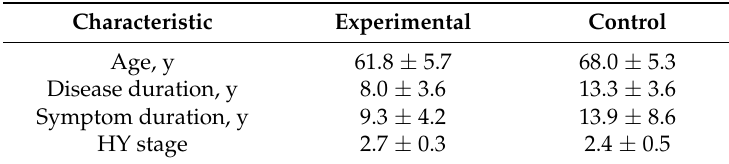
Table 2. Comparison of baseline characteristics of the experimental and control